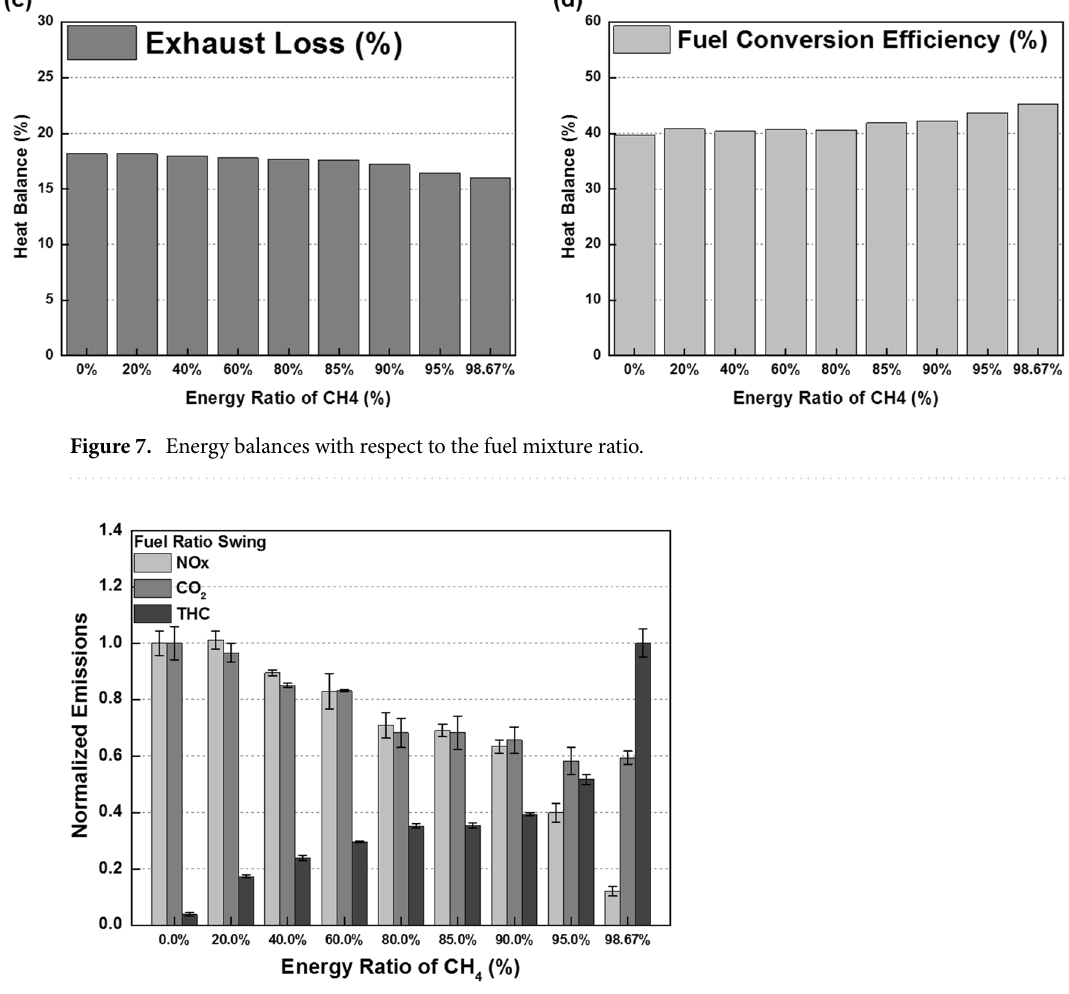
Figure 8. Emission gases with respect to the fuel mixture